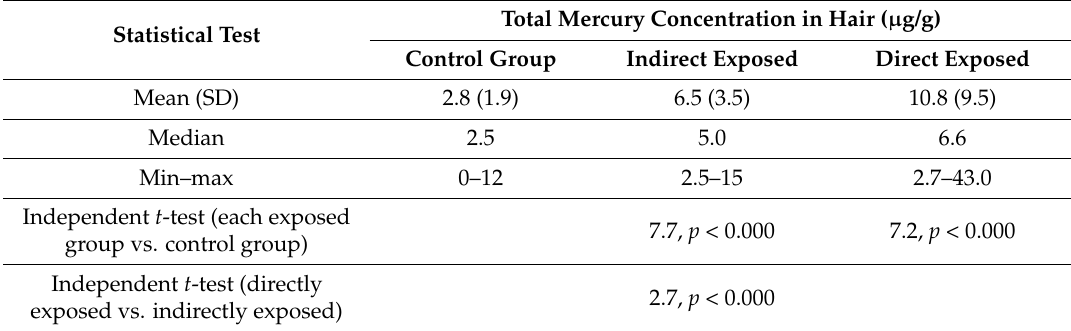
Table 2. Total mercury concentration in the hair of the control group and exposed group.